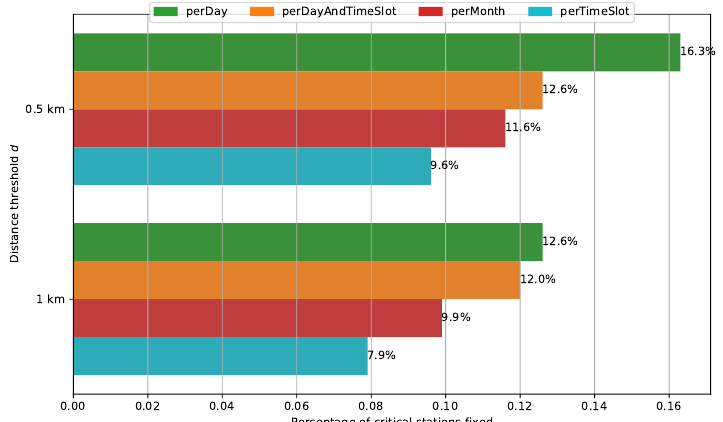
Figure 13. Percentage of fixed stations with 500 m and 1 km neighbourhood radius.